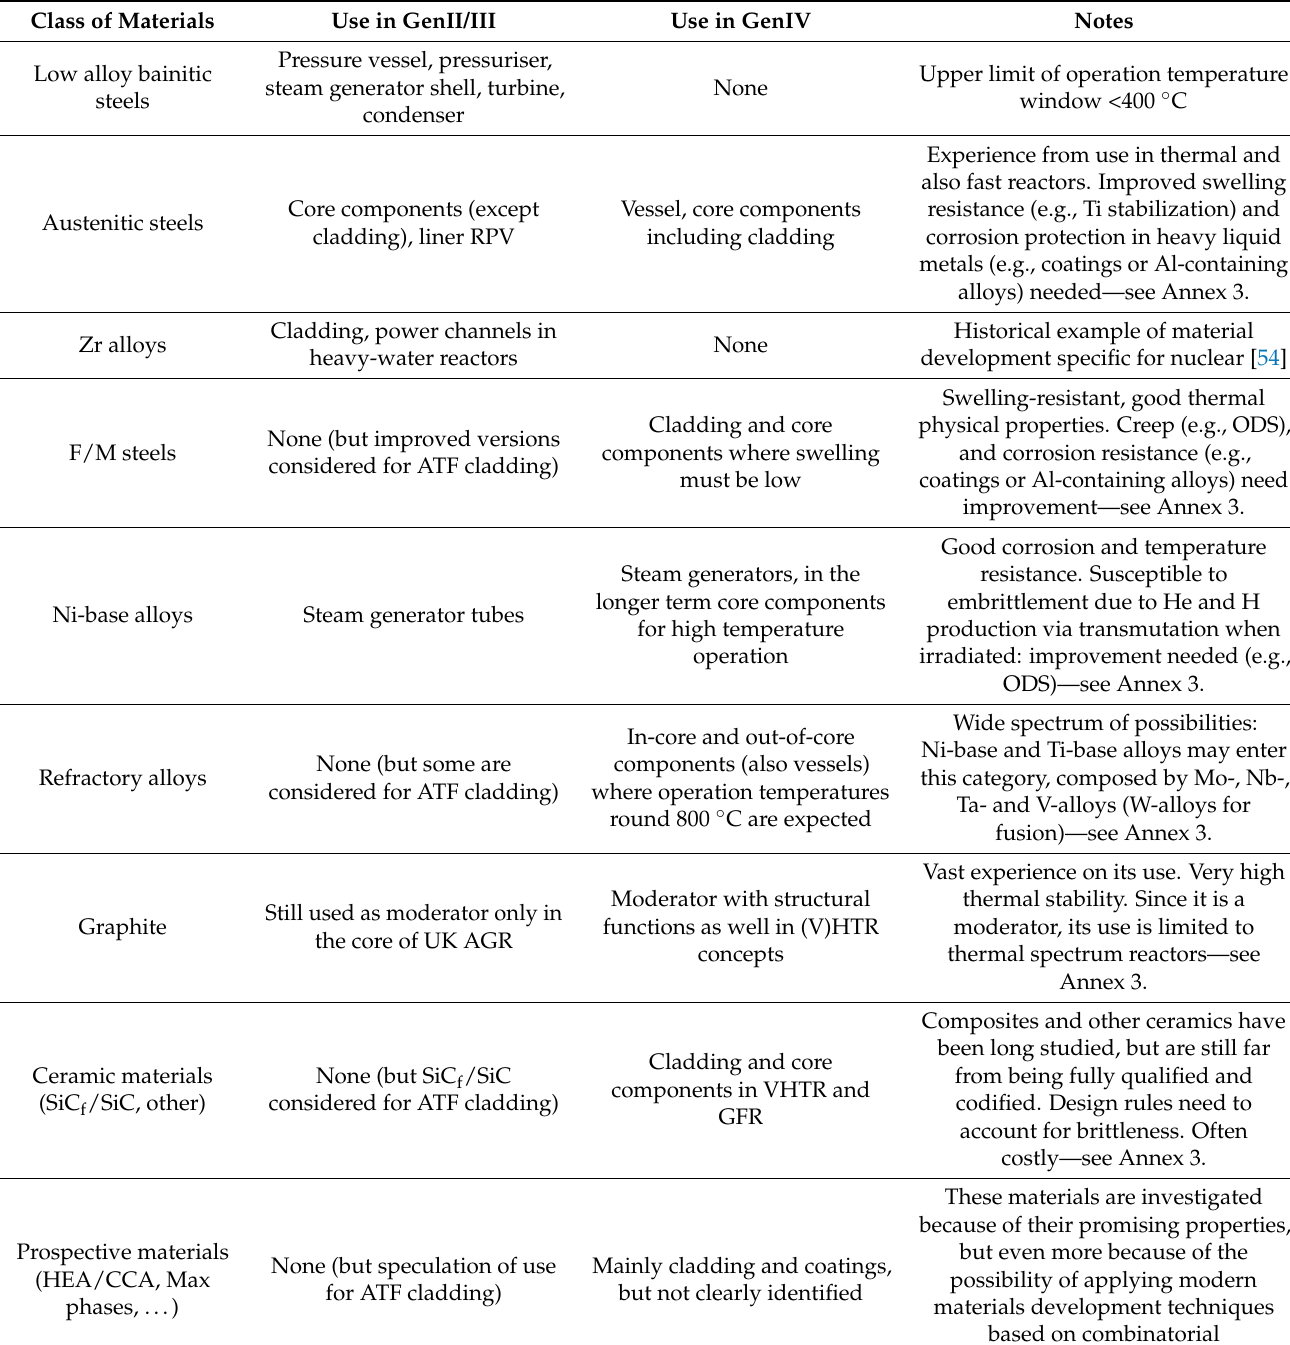
Table 2. Summary of classes of structural materials through reactor generations. RPV = reactor pres- sure vessel, F/M = ferritic/martensitic, ATF = accident tolerant fuel, ODS = oxide dispersion strength- ened, AGR = advanced gas reactor, (V)HTR = (very) high temperature reactor, GFR = gas-cooled fast reactor, HEA = high entropy alloys, CCA = compositionally complex